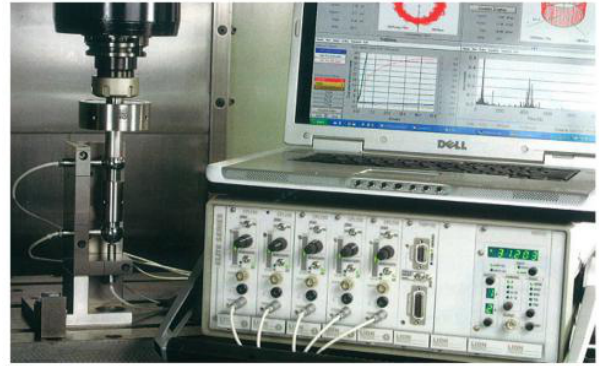
Figure 12. Stand for testing spindle error movements [22].